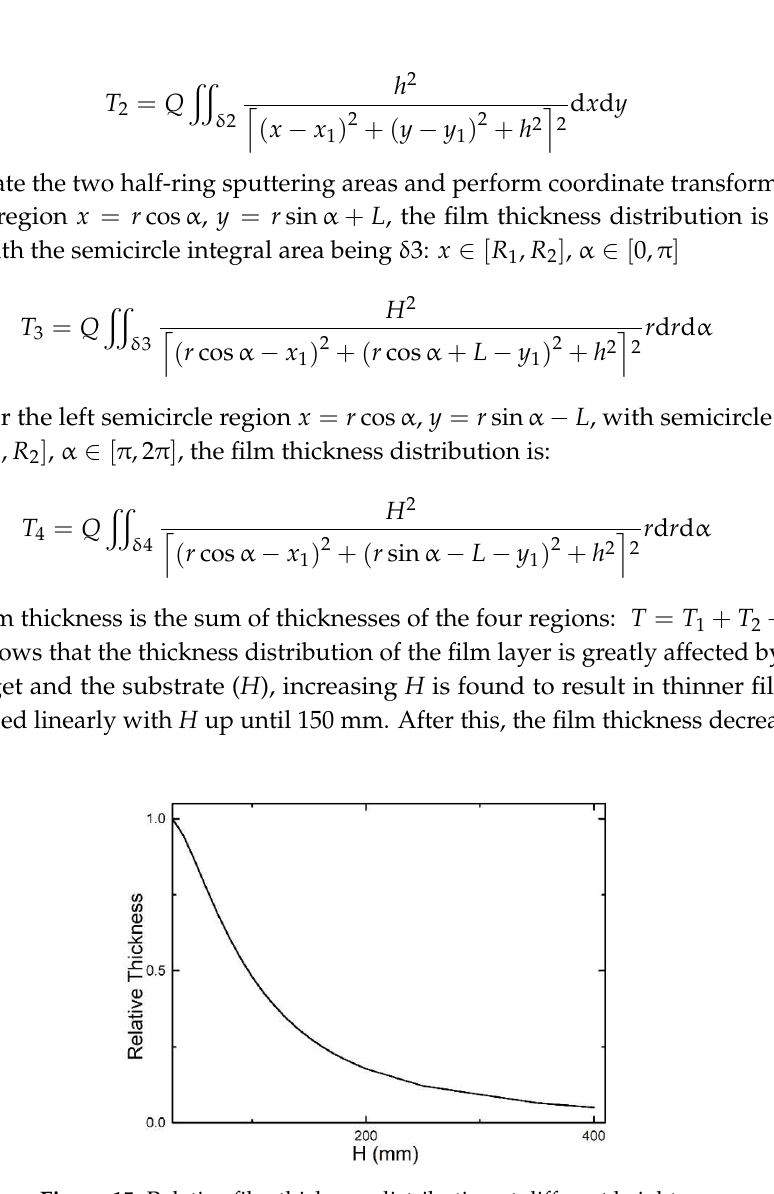
Figure 16. Relative film thickness distribution at X 1 positions, as described in Figure 14.